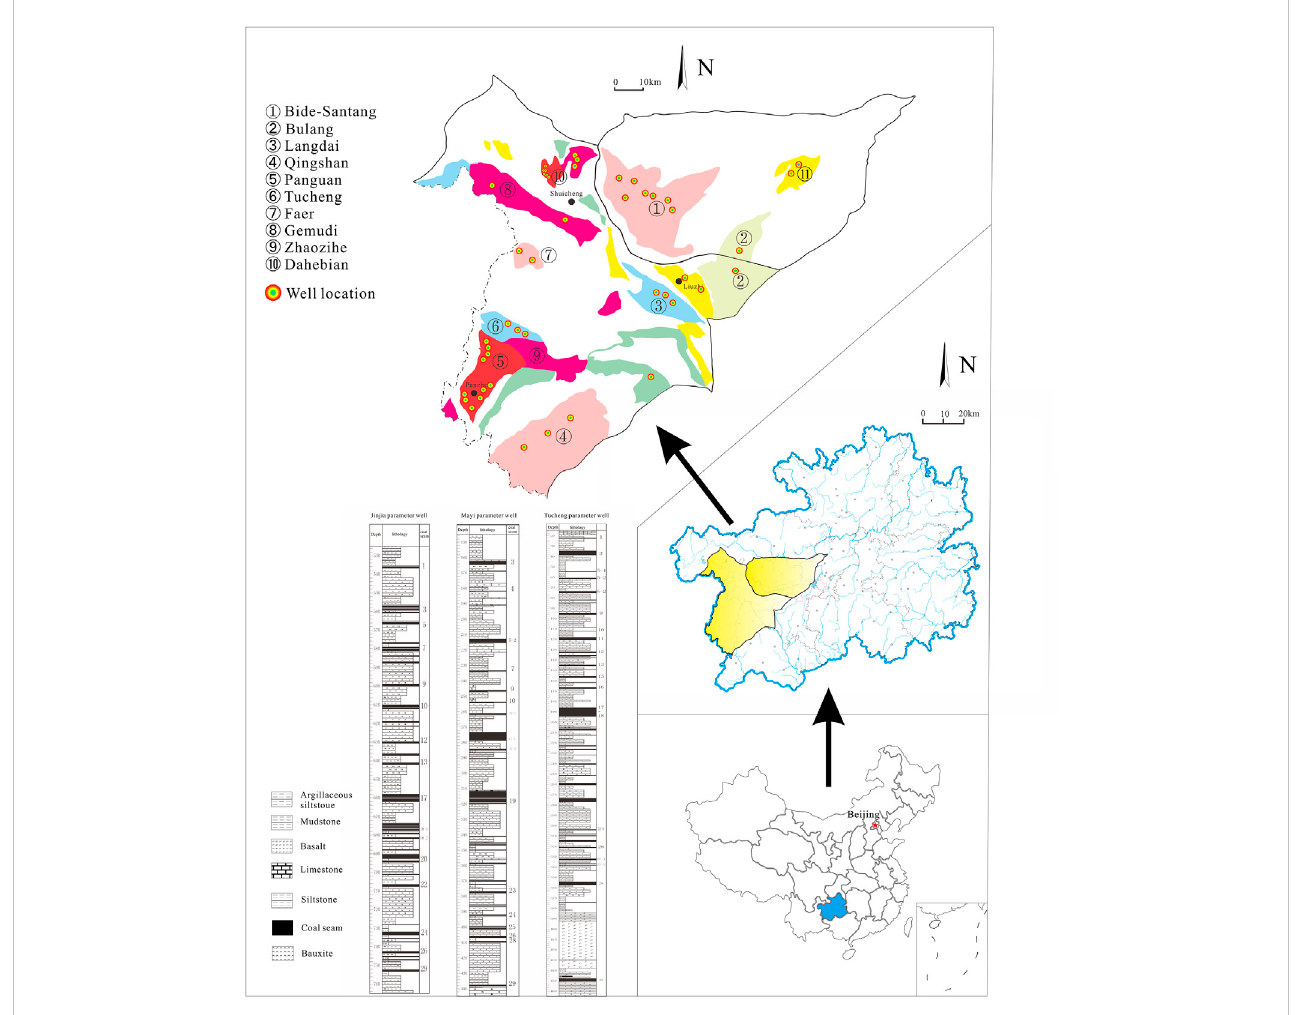
FIGURE 1 Location of western Guizhou in China and coal bearing strata